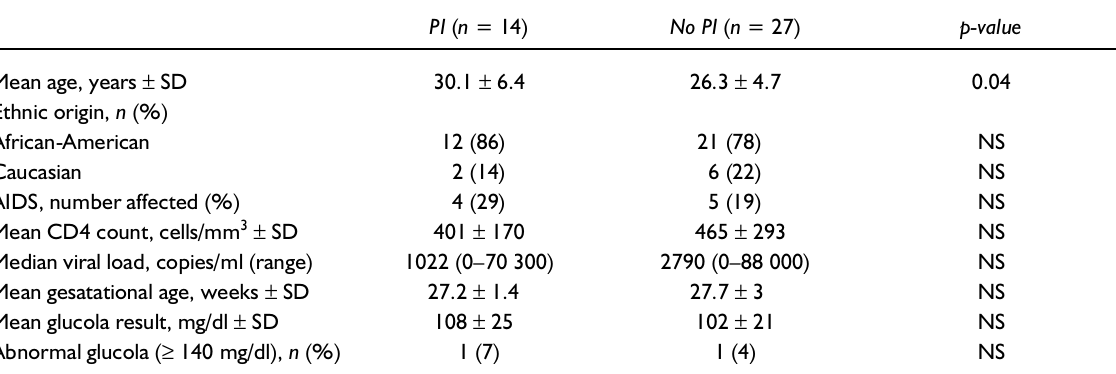
Table 1 Characteristics of HIV-infected pregnant women at the time of glucola testing, comparing those taking protease inhibitors (PI) and those who were not (No